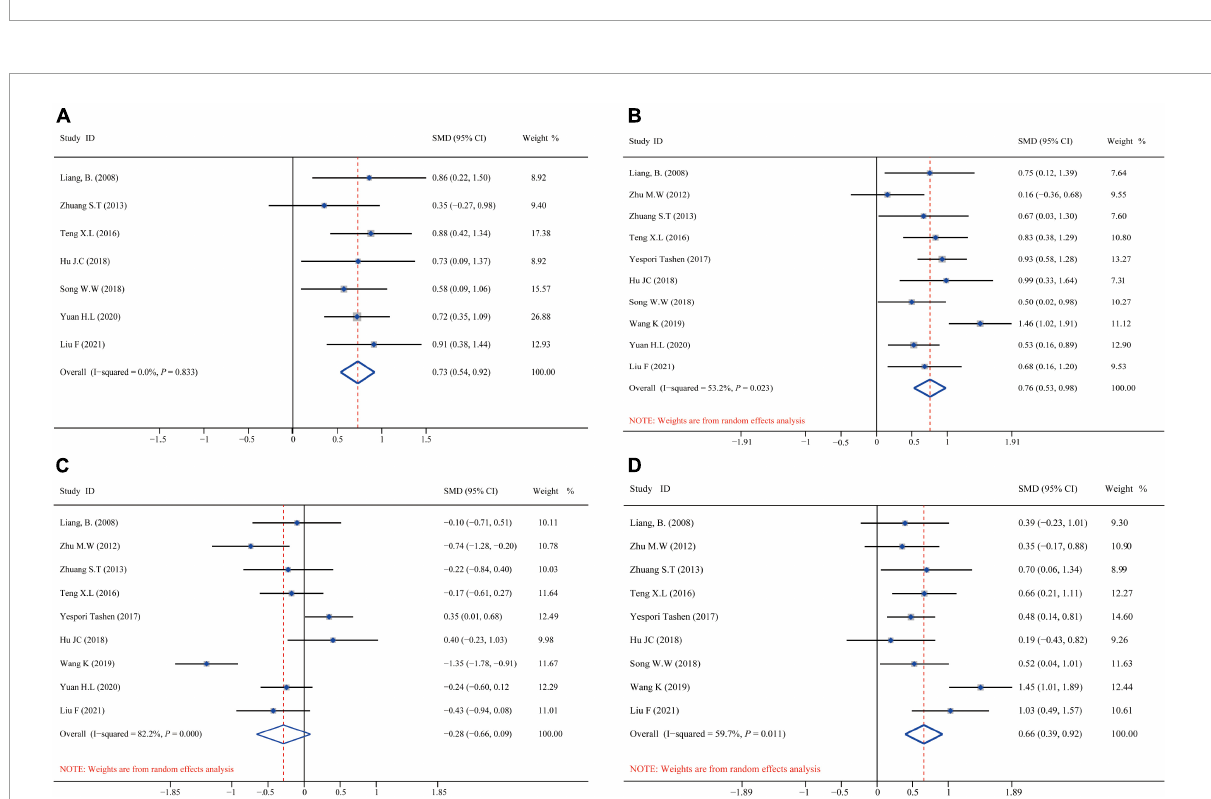
FIGURE5 Forest plot and SMD presentation for CD3 + , CD4 + , CD8 + , and CD4 + /CD8 + . (A) Forest plot of CD3 + ; (B) forest plot of CD4 + ; (C) forest plot of CD8 + ; and (D) forest plot of CD4 + /CD8 + . In all aggregated analyses, CD3 + used fixed-effect model, and CD4 + , CD8 + , CD4 + /CD8 + used random-effects